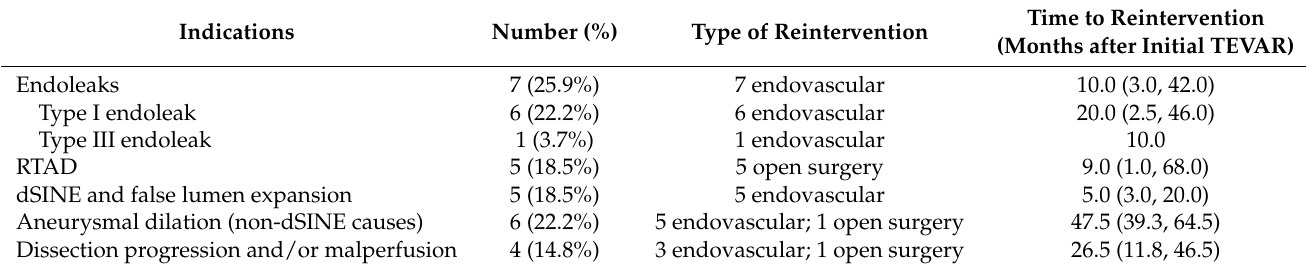
Table 5. Univariate and multivariate Cox hazard analysis of reintervention.